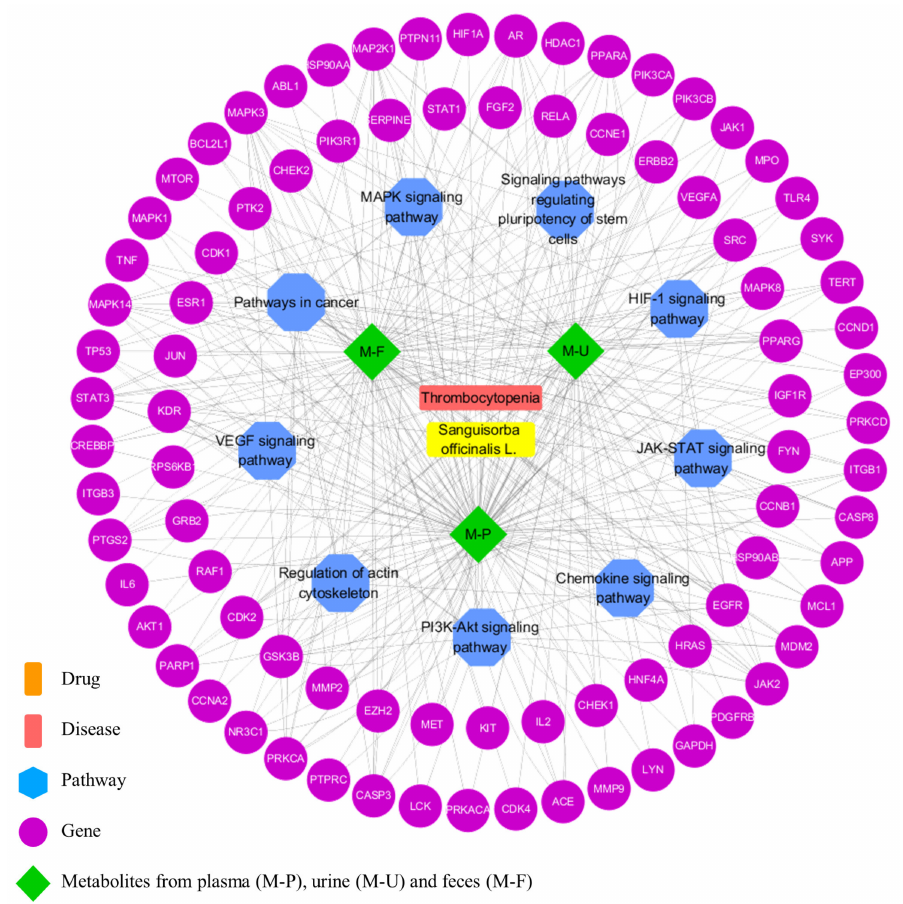
Figure 4. Targets/pathways/disease network of SO metabolites and thrombocytopenia. The targets of metabolites were marked in purple, the pathways were marked in blue, metabolites were marked in green, diseases were marked in red, and SO was marked in